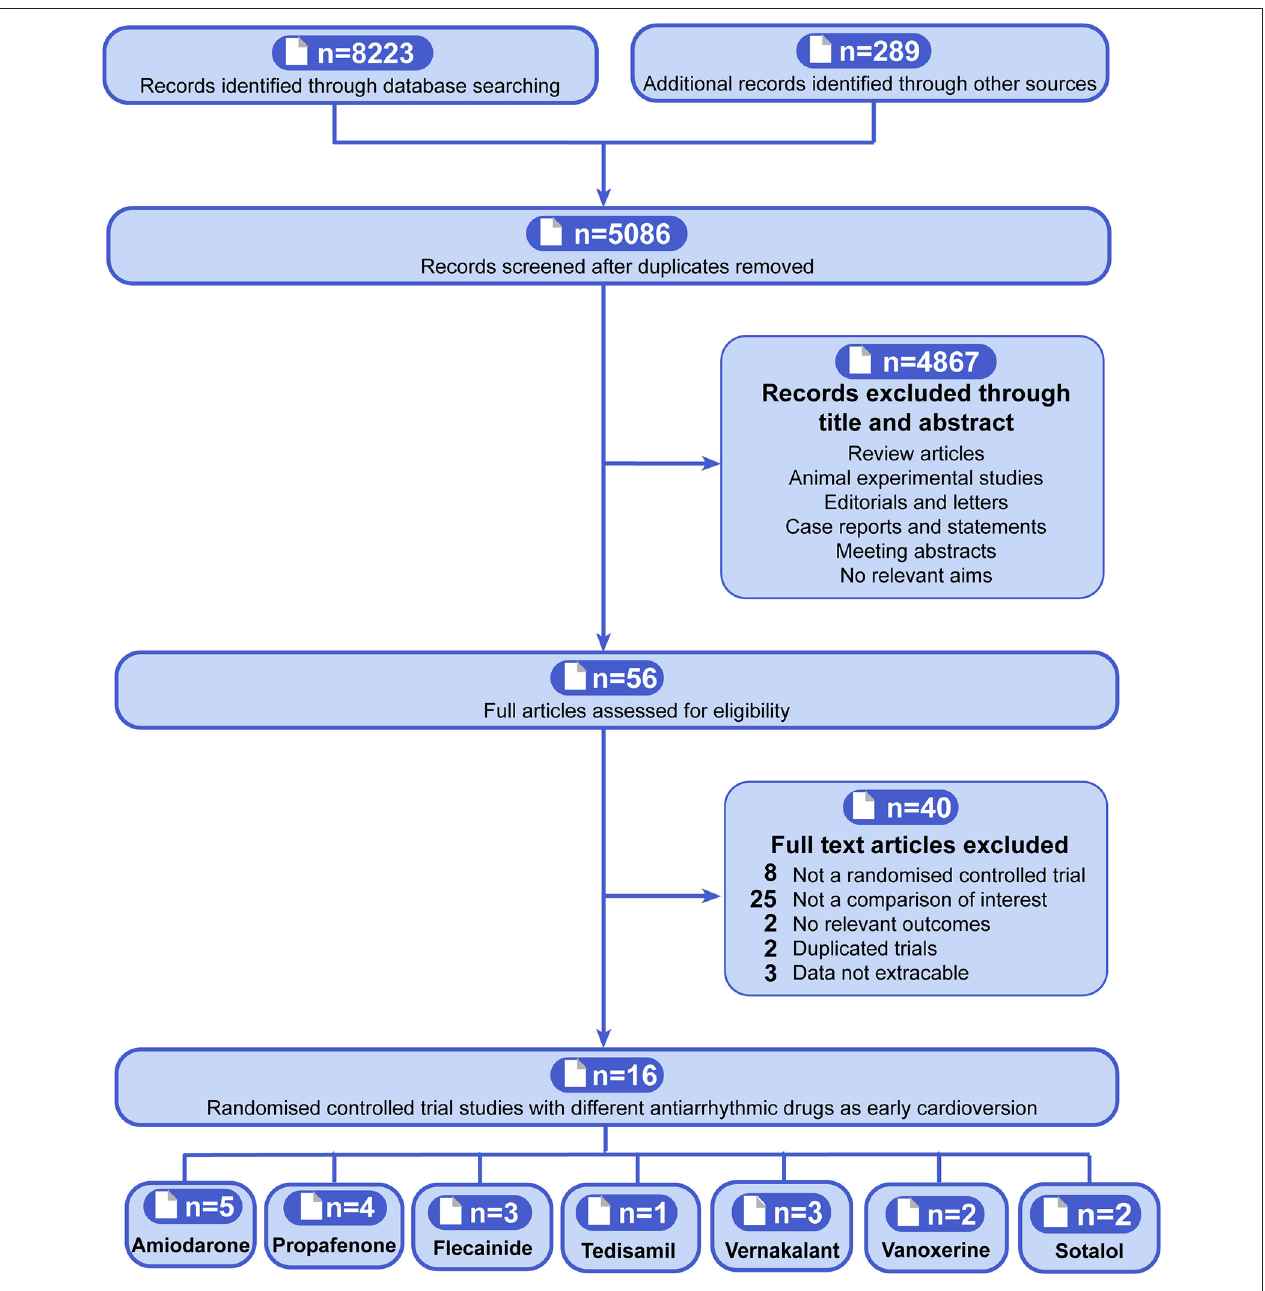
FIGURE 1 | Flowchart showing the procedure for identifying the relevant publications. The antiarrhythmic drugs as early pharmacologic cardioversion in the study included amiodarone, propafenone, flecainide, tedisamil, vernakalant, vanoxerine, and sotalol.